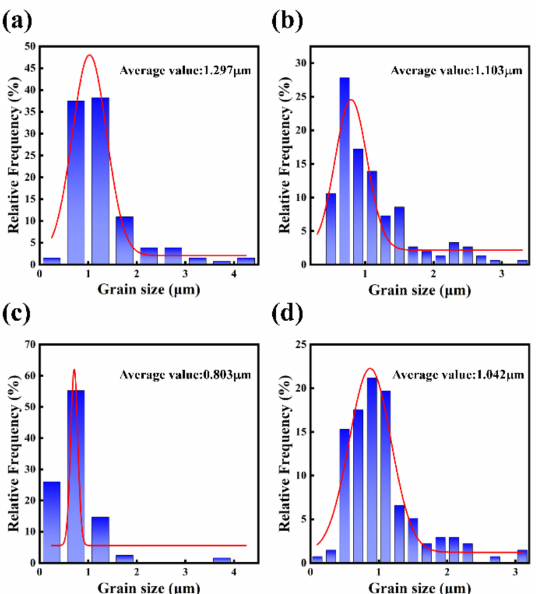
Figure 3. SEM/BSE images of (Ti,W)C-xTa-based cermets, x in wt.%: ( a ) x = 0, ( b ) x =1, ( c ) x = 3, and ( d ) x = 5.